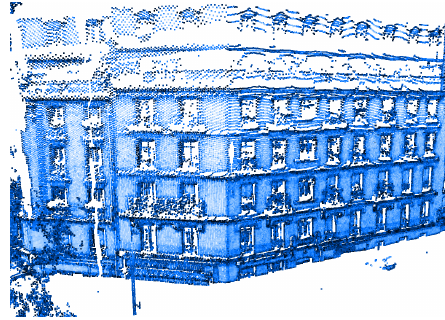
: 0 (light blue) → 1 (dark blue). f